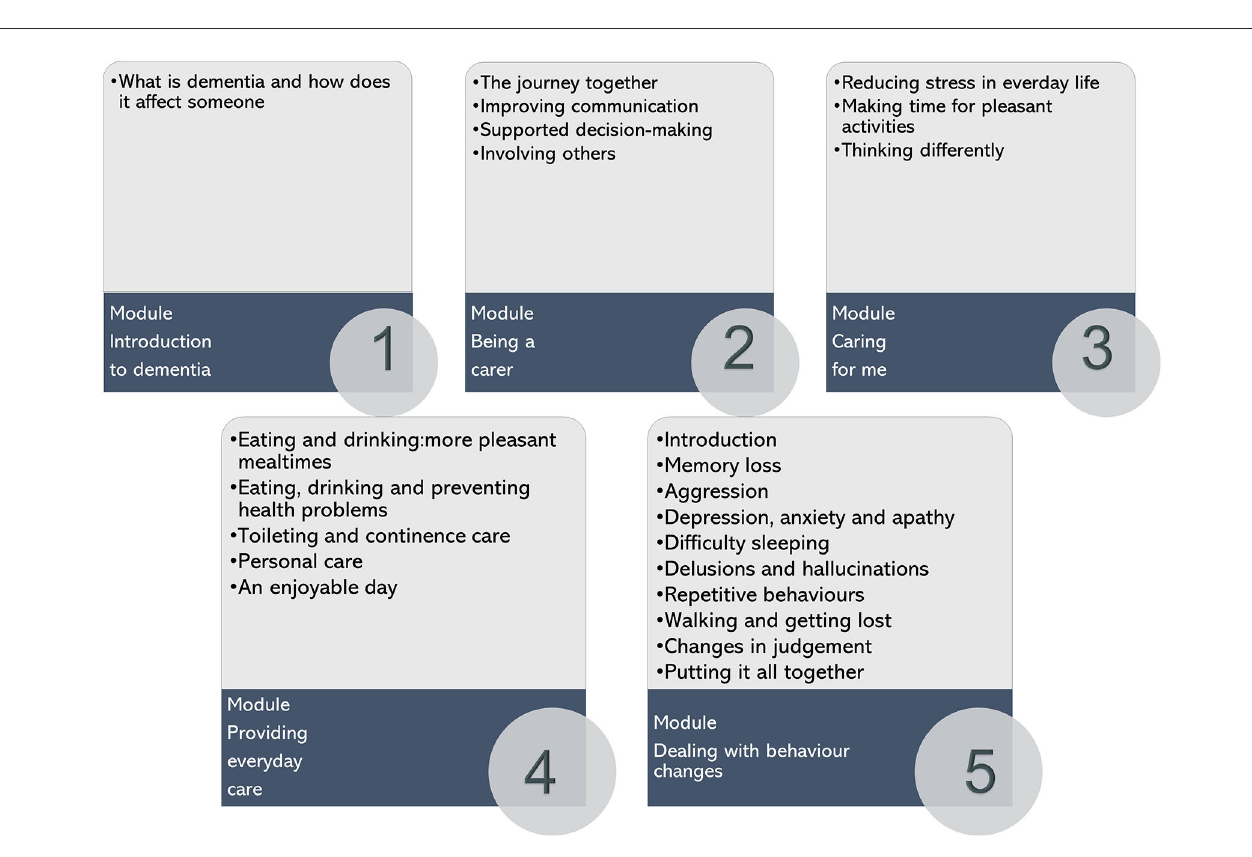
FIGURE2 Overview of the iSupport online self-help training and support programme: Structure and contents